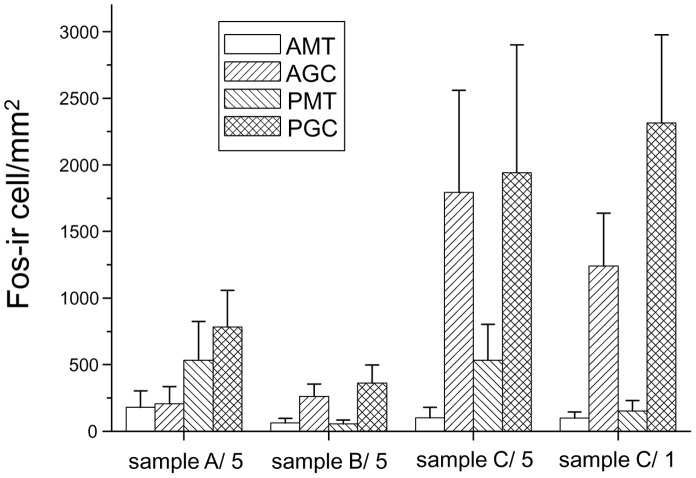
Density of Fos-immunoreactive cells (number of cells/mm2) in the MTC and GC layers in the anterior and posterior regions of the AOB after exposure to undiluted wolf urine sample C (sample C/1) or 5-fold diluted samples A, B or C (sample A/5, sample B/5, sample C/5).The statistical significance of the differences between sample C vs. samples A and B was assessed by ANOVA followed by Fisher’s PLSD post-hoc test. The density of Fos-immunoreactive (Fos-ir) cells in the anterior GC layer was higher after exposure to diluted sample C relative to diluted sample A (P<0.01) or diluted sample B (P<0.01); similarly, the density of Fos-immunoreactive cells in the posterior GC layer was higher after exposure to diluted sample C vs. diluted sample A (P<0.05) or diluted sample B (P<0.01). Furthermore, the density of Fos-immunoreactive cells was higher after exposure to undiluted sample C vs. diluted sample A (P<0.01) or diluted sample B (P<0.005). AMT and PMT, anterior and posterior mitral cell layer; AGC and PGC, anterior and posterior granule cell layer.